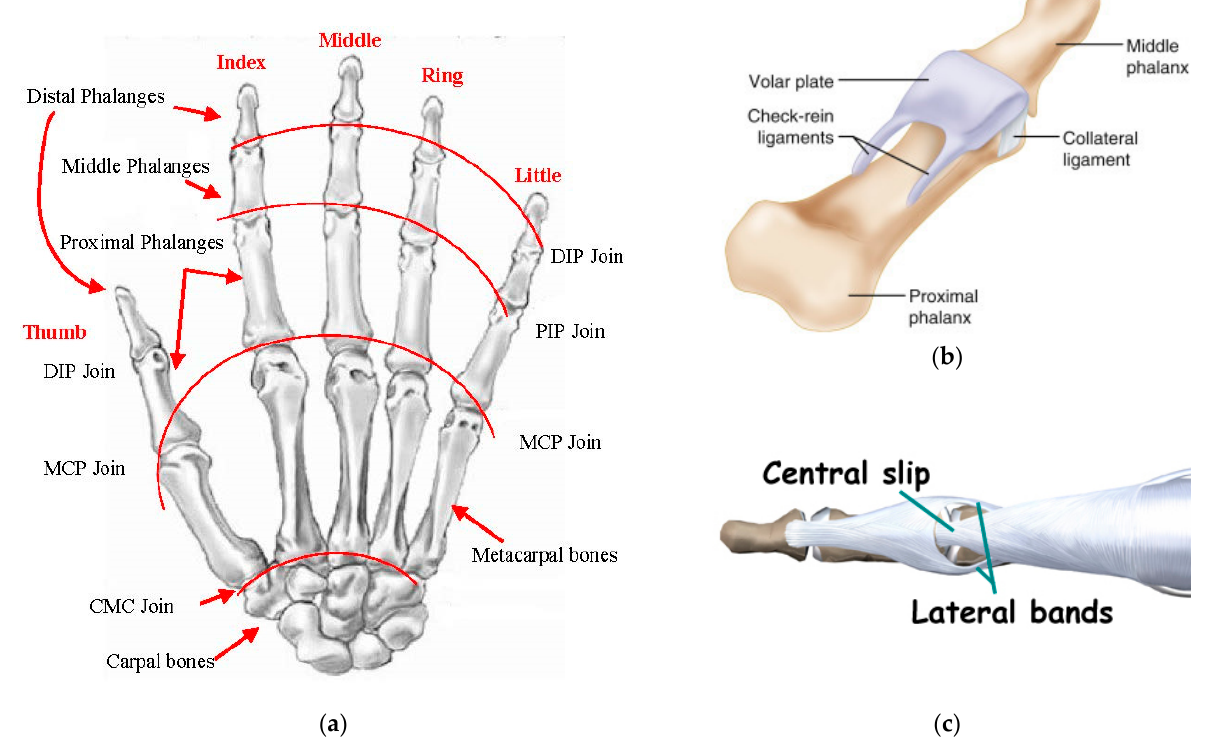
Figure 1. Human hand anatomy. ( a ) Human hand bones and joins; ( b ) volar plate and collateral ligaments; ( c ) extensor hooks.